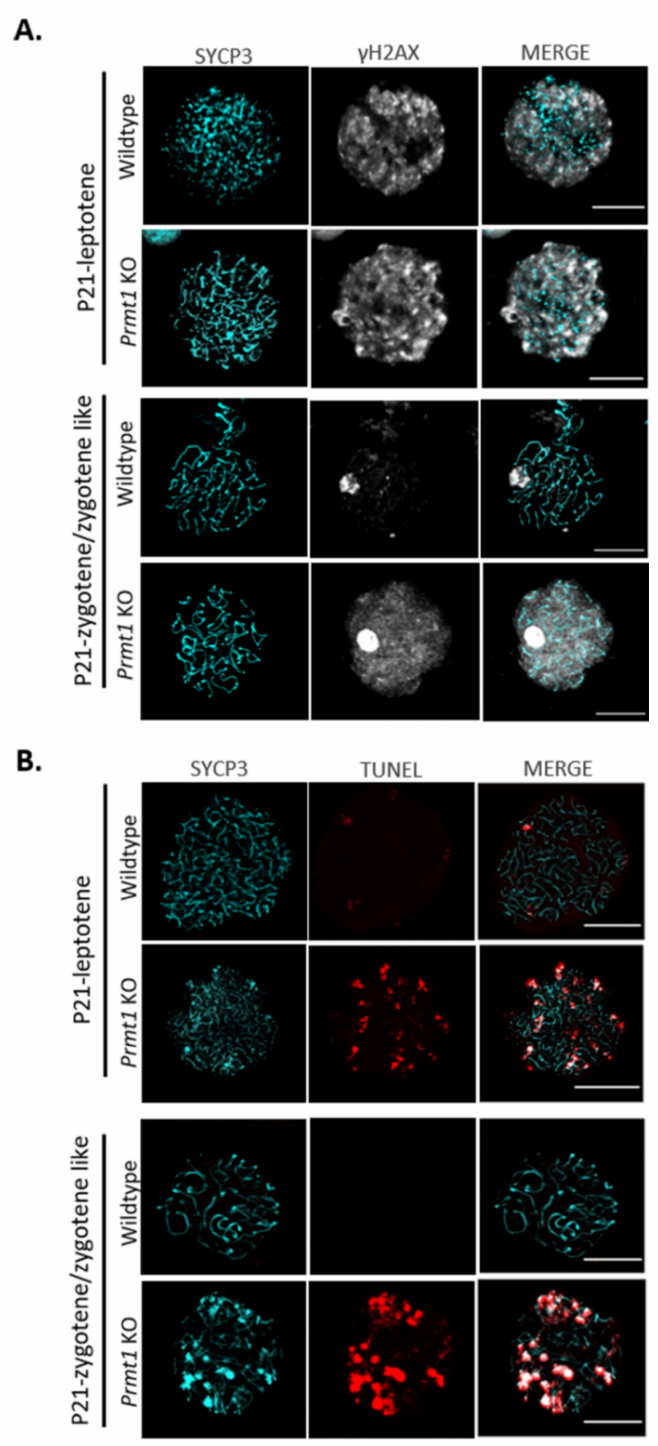
Figure 5. PRMT1-deficient germ cells accumulate DNA double-strand breaks. ( A ) Immunofluo- rescence staining for the detection of γ H2AX and SYCP3 on nuclear surface spreads of leptotene, zygotene, or zygotene-like spermatocytes from wildtype and Prmt1 KO testes on P21. Scale bar, 200 µ m. ( B ) TUNEL staining of the nuclear surface spreads of leptotene, zygotene, or zygotene-like spermatocytes from wildtype and Prmt1 KO testes on P21. Scale bar, 200 µ m. Each experiment was repeated at least three times